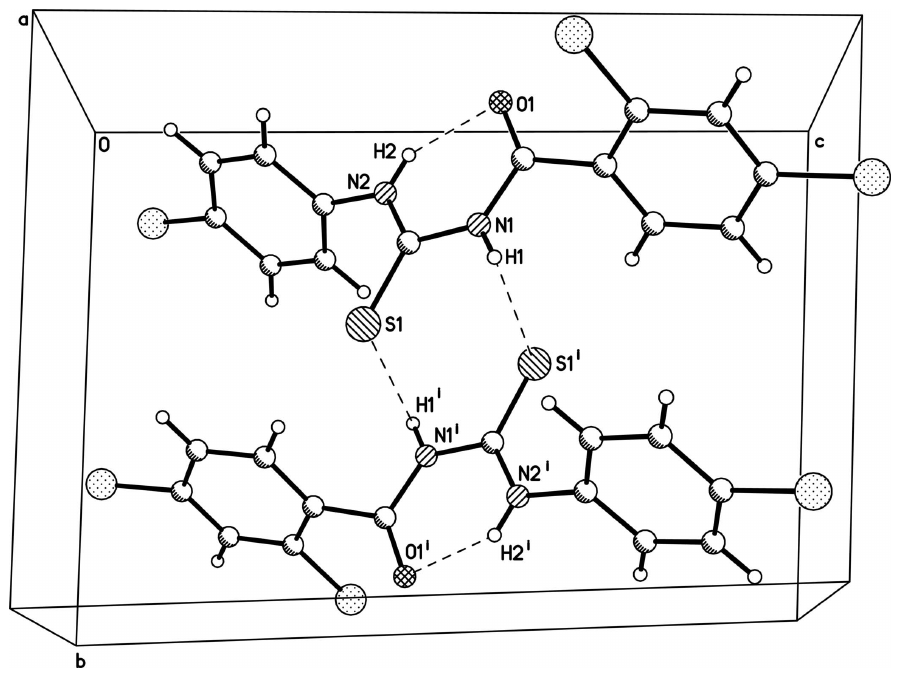
Figure 2 Packing diagram of the title compound with view onto the bc plane. Hydrogen bonds are shown as dashed